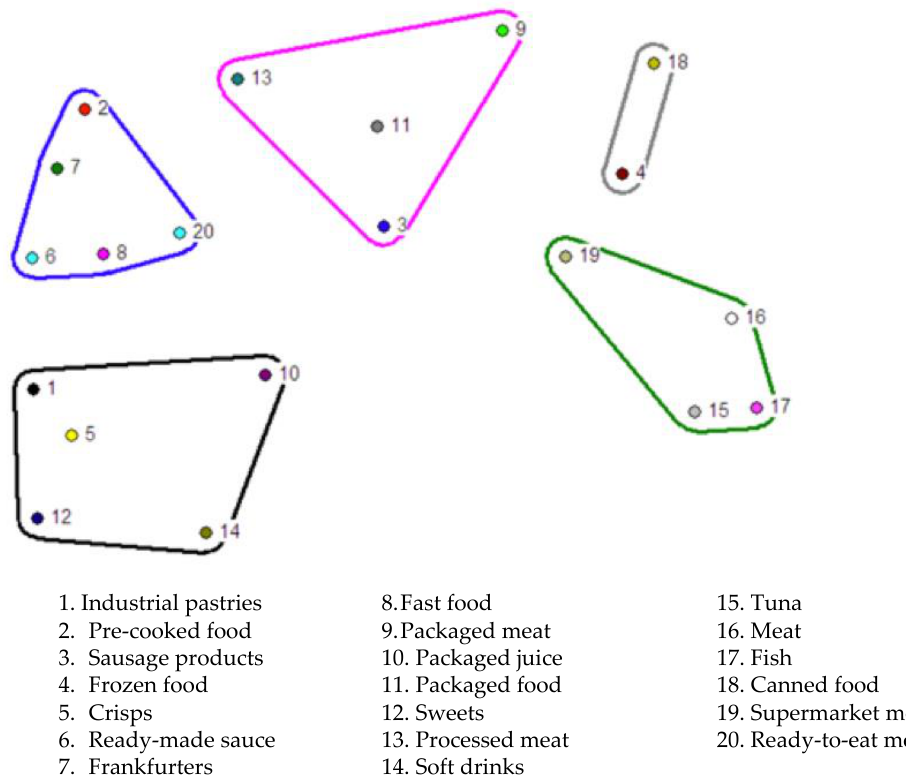
Figure 4. Nonmetric multidimensional scaling (nMDS) of distrust in food. Representation of the total number of pile sorts ( n = 62) showing the proximity/distance of the categories in the women’s perceptual universe. The nMDS model allows for various interpretations and therefore the proposed item areas are tentative. The numbering corresponds to the following categories. Interpretation of the clusters or dimensions: blue: prepared or pre-cooked food; black: highly artificial processed products with many added chemical substances; pink: basic processed products; green: products that are distrusted due to their origin, manipulation and/or distribution; grey: products that are distrusted because of concerns about added preservatives.